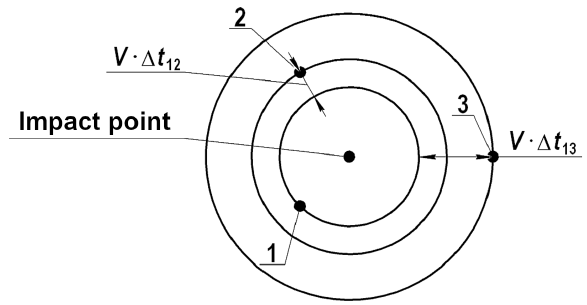
Figure 2. Graphic representation of the TDOA-based acoustic anomaly localization method: 1, 2, 3 are the sensor sensors num- bered according to the time of arrival.